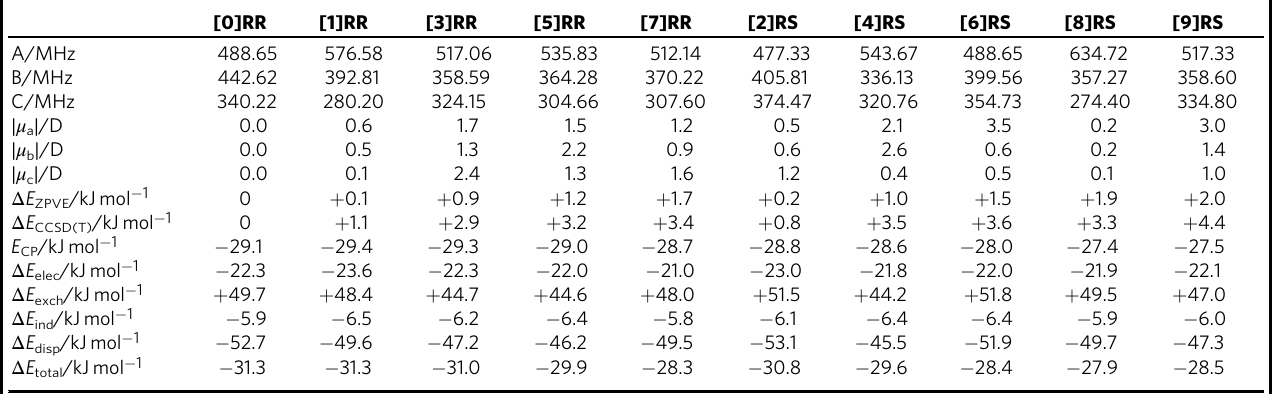
Table 1 Calculated spectroscopic parameters for homochiral and heterochiral dimers of styrene oxide. [0]RR